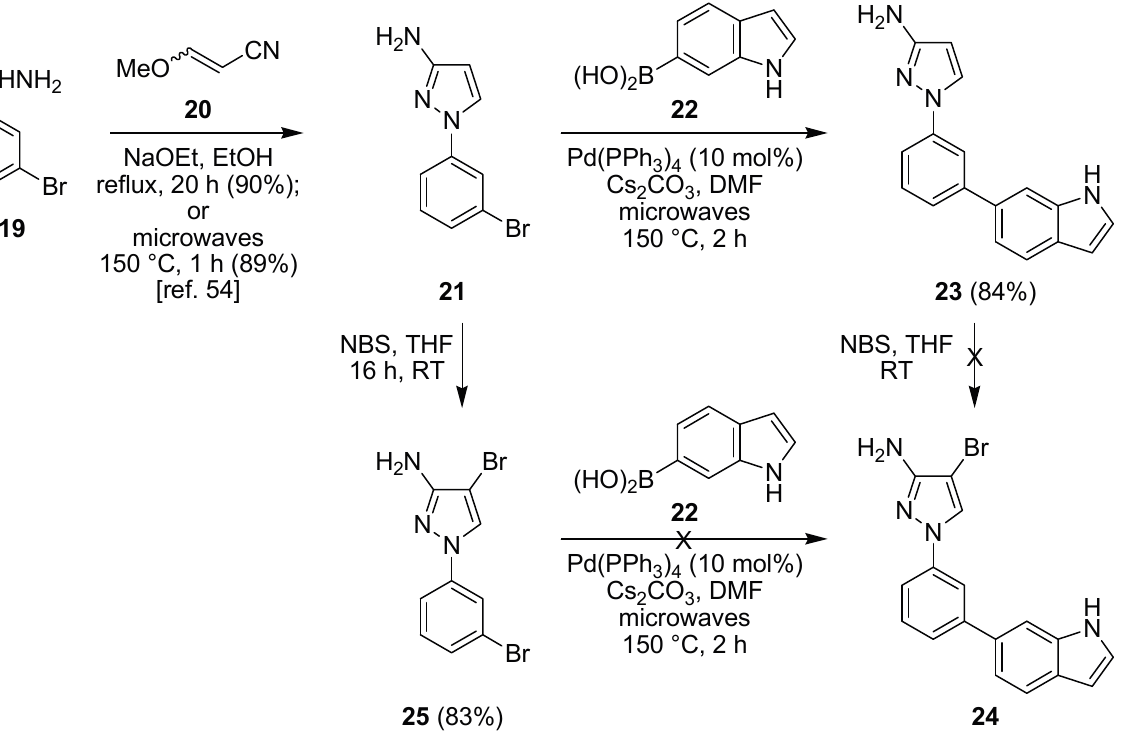
Figure 8. Suzuki-Miyaura cross-coupling for the synthesis of 6-indolyl